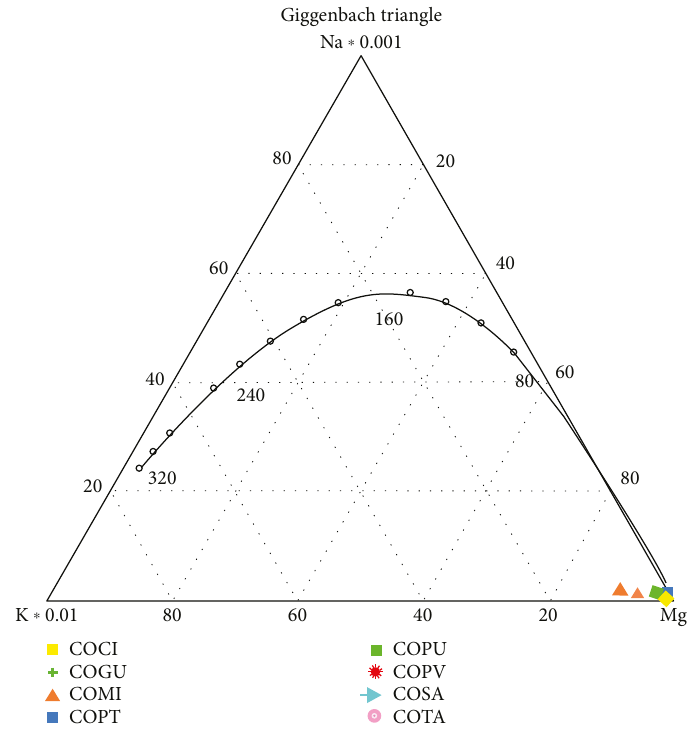
Figure 8: Ternary diagram of cations for the sources in Puracé-La Mina